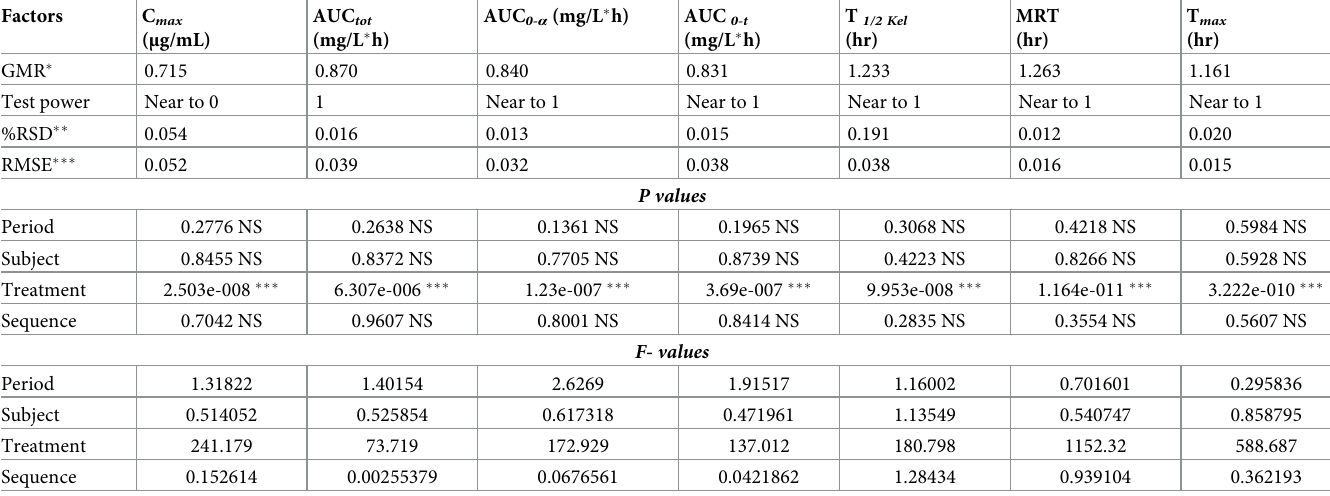
Table 5. Log transformed pharmacokinetics parameters of amoxicillin alone and in combination for inter and intra subject variability.